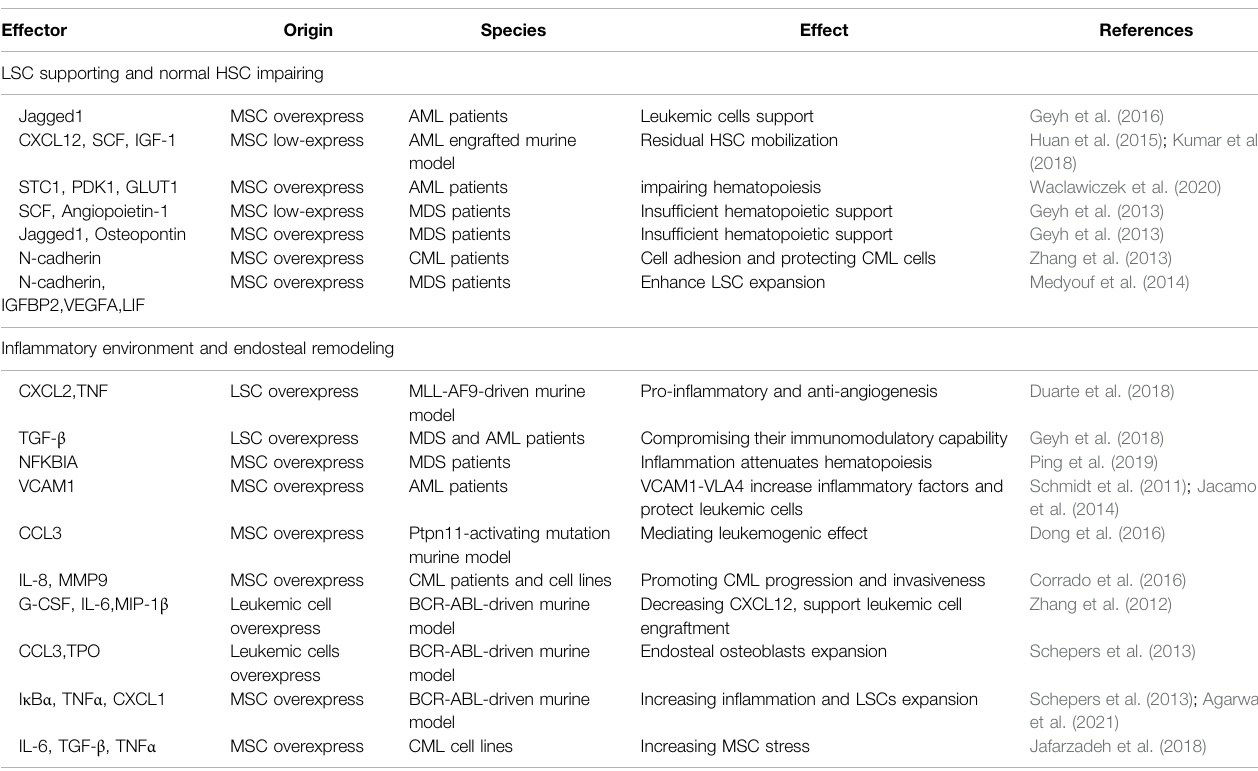
TABLE 2 | Numerous cytokines and chemokines are involved in leukemia niche